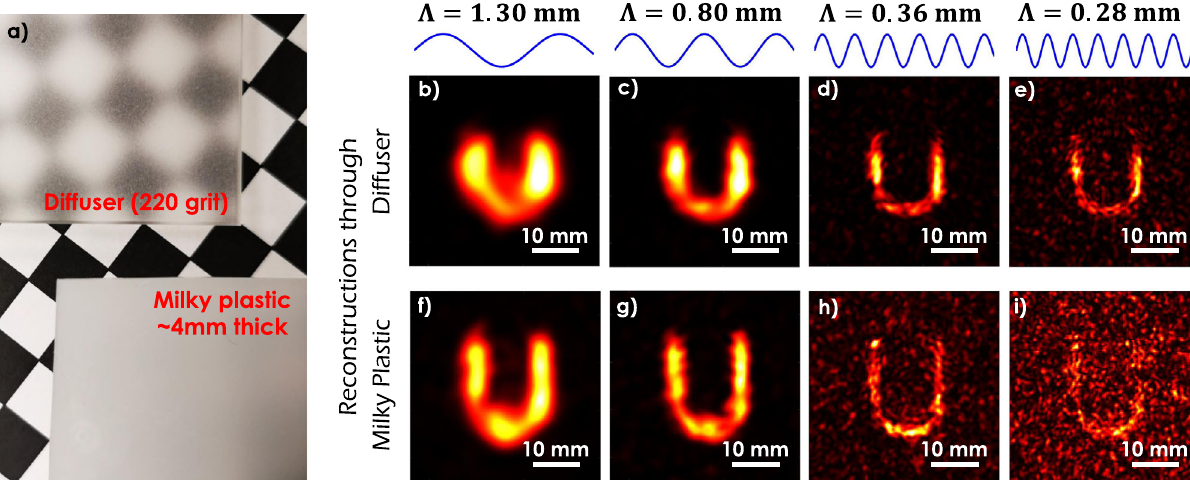
Fig. 3 Experimental demonstration of imaging through scattering media using SWH. A schematic of the experimental setup is available in Fig. 1c. a Scatterers obscuring the object: A 220-grit ground glass diffuser and a milky white plastic plate of ~4 mm thickness, both placed ~1 cm over a checker pattern to demonstrate the degradation in visibility. b – e Reconstructions of measurements taken through the ground glass diffuser for different SWLs Λ . f – i Reconstructions of measurements taken through the milky plastic plate for different SWLs Λ . The character can be reconstructed with impressive quality. The larger OPD in the plastic plate leads to greater decorrelation if the SWL is